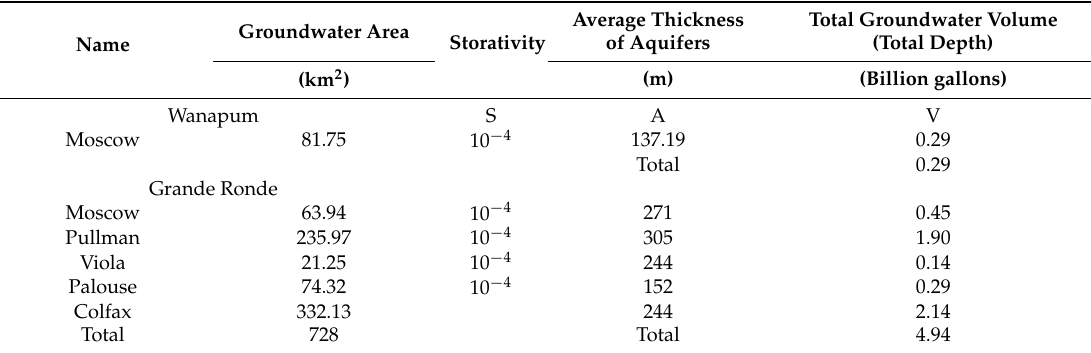
Table 4. Initial Volume of Groundwater in